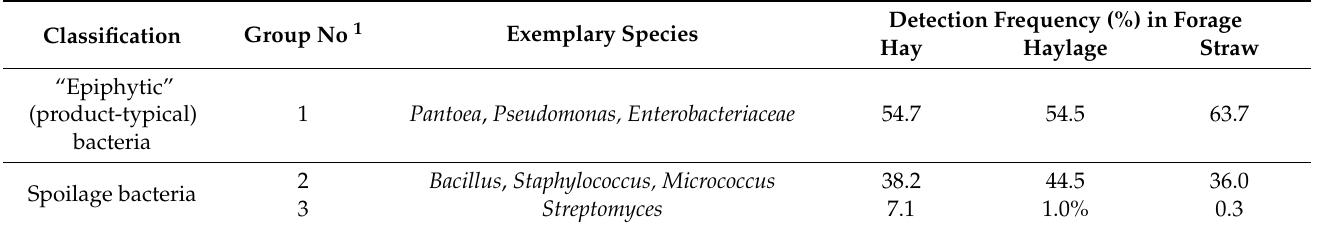
Table 5. Proportional detection frequency of aerobic bacteria classified in groups according to VDLUFA [51] in hay, haylage, and straw.